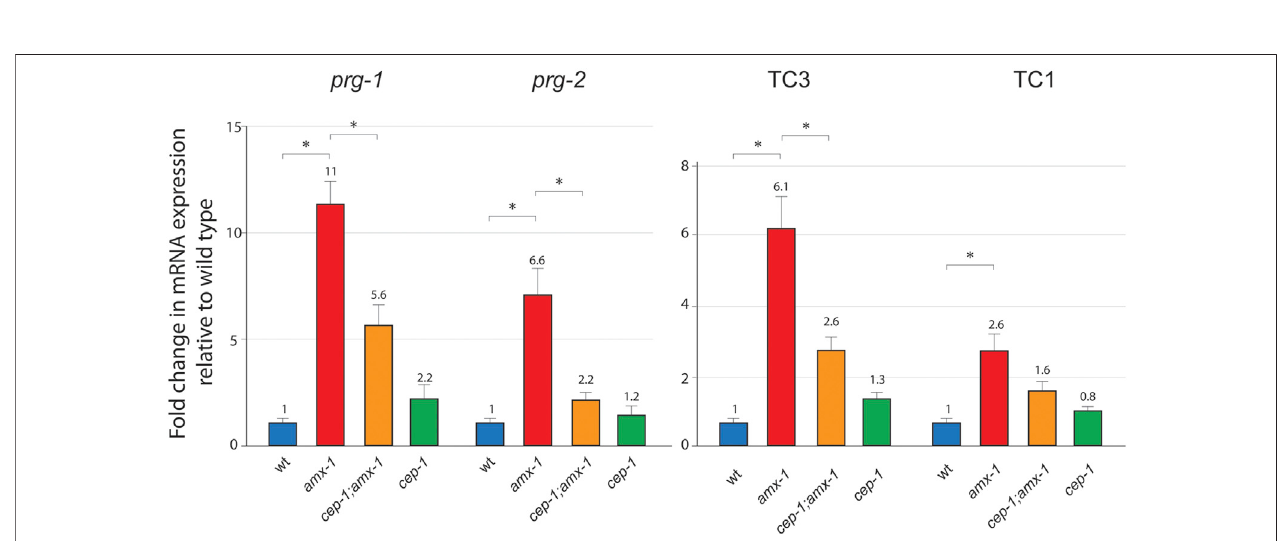
FIGURE 6 | AMX-1 is required for the proper expression of Piwi and transposon silencing. Changes of relative mRNA expression levels of Piwis ( prg-1 and prg-2 ) and transposons (Tc3 and Tc1). Lack of amx-1 expression increases Piwi expression. mRNA expression was monitored with qPCR primers spanning exon-exon junctions for each indicated genes. The data shown are the means with SEM analyzed employing an unpaired, two-tailed t -test. Assay repeated at least three independent sample preparations. Tubulin encoding tba-1 was used as an endogenous reference. Asterisks indicate signi fi cant changes of mRNA expression.